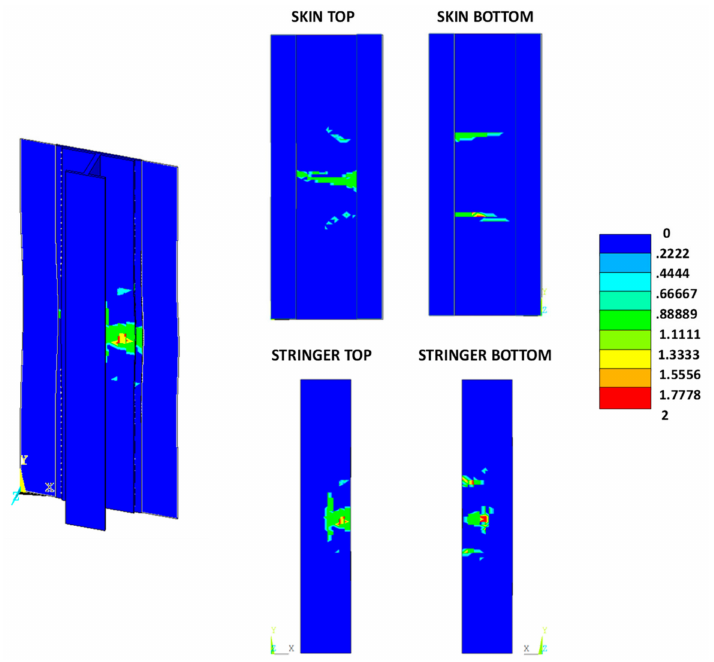
Figure 16. Damage status: reference material system.